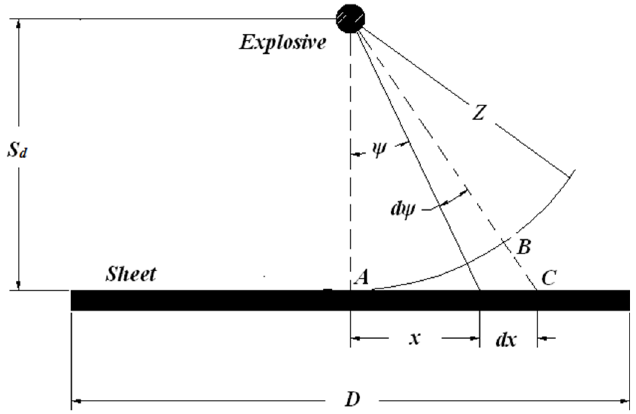
Fig. 5. Impulse transmitted from the explosive to the